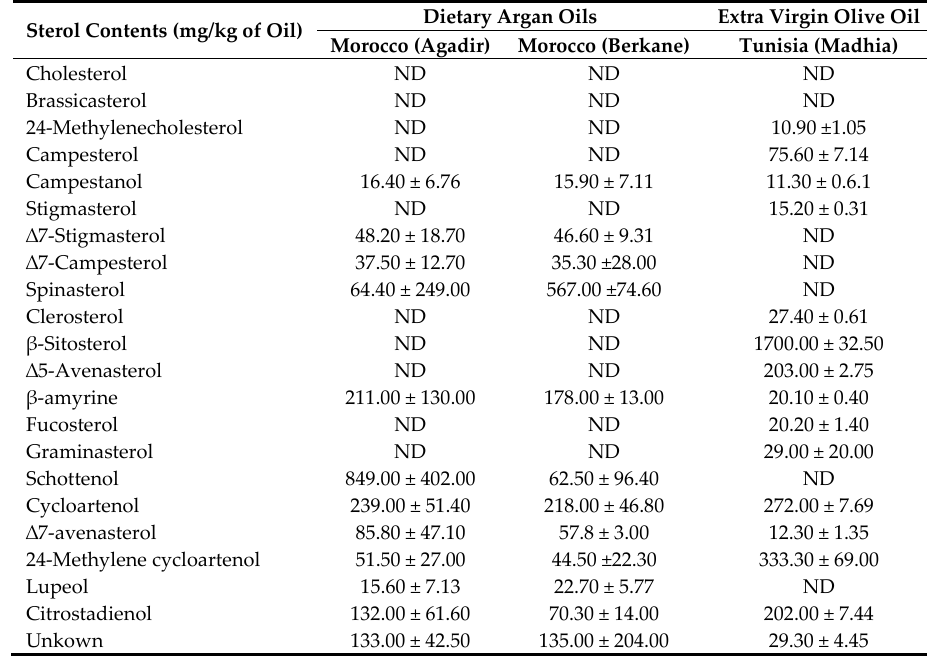
Table 2. Sterols content of dietary argan oils (Agadir, Berkane; Morocco) and extra virgin olive oil (Madhia, Tunisia).